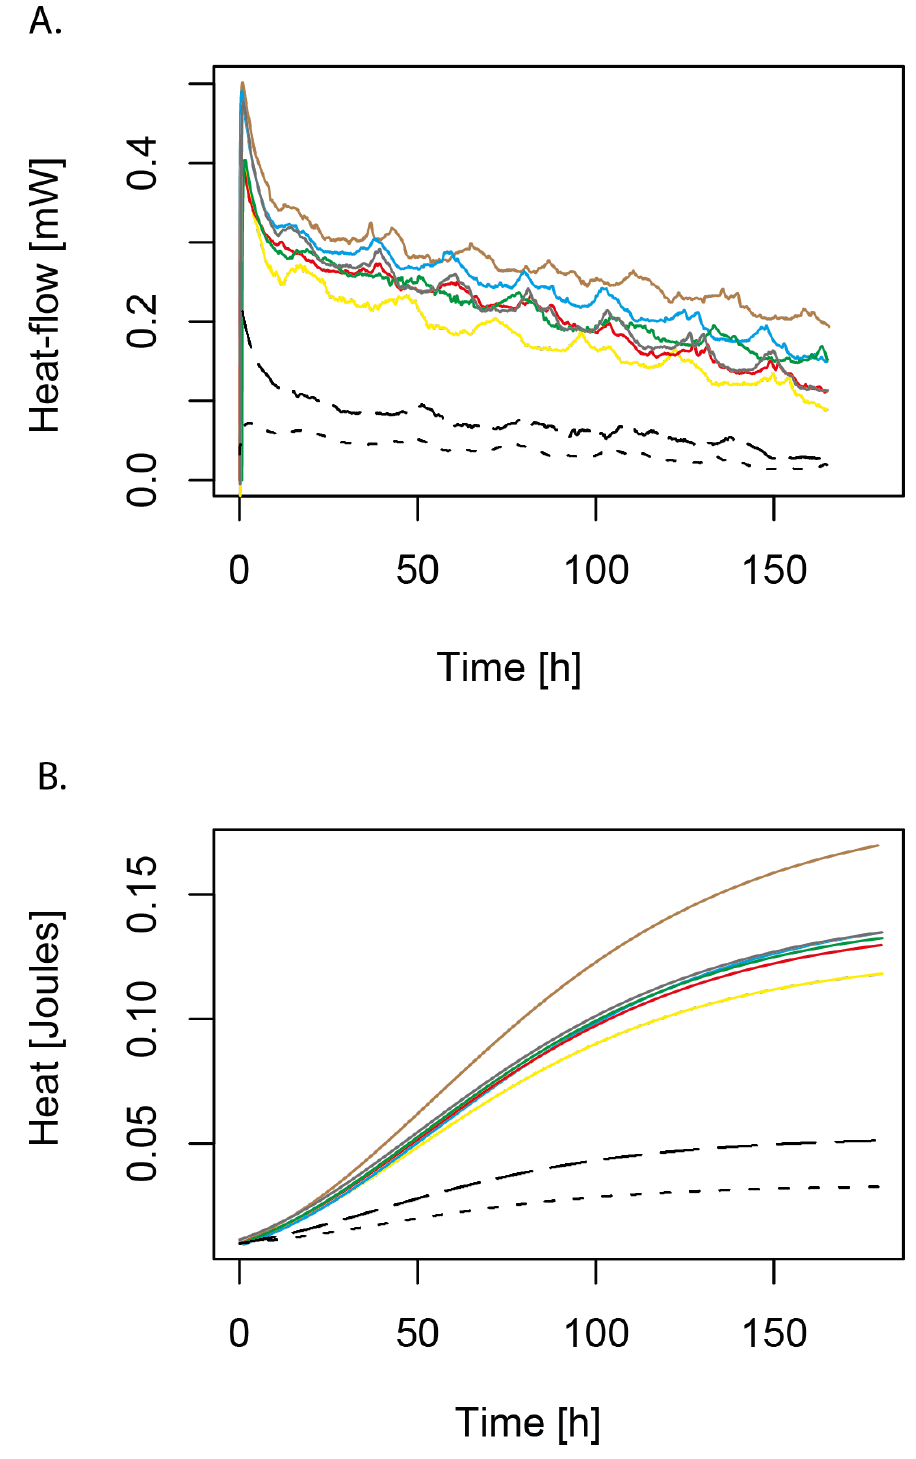
Figure 2. Calorimetric thermograms of bacterial metabolic activity. ( A ) The metabolic activity of CdtB strains by the heat flow compared to referential bacterial controls amended with cadmium in liquid culture media. ( B ) The heat produced in Joules due to the Cd immobilization activity of the assessed CdtB. Each color corresponds to the heat flow and the heat produced by one CdtB strain. Yellow = CdtB3, red = CdtB6, blue = CdtB7, green = CdtB13, brown = CdtB14, gray = CdtB41 (positive control), long dashed line = strain E. coli K12 DSM498 (negative control) and short dashed line = Mergeay ’ s medium.